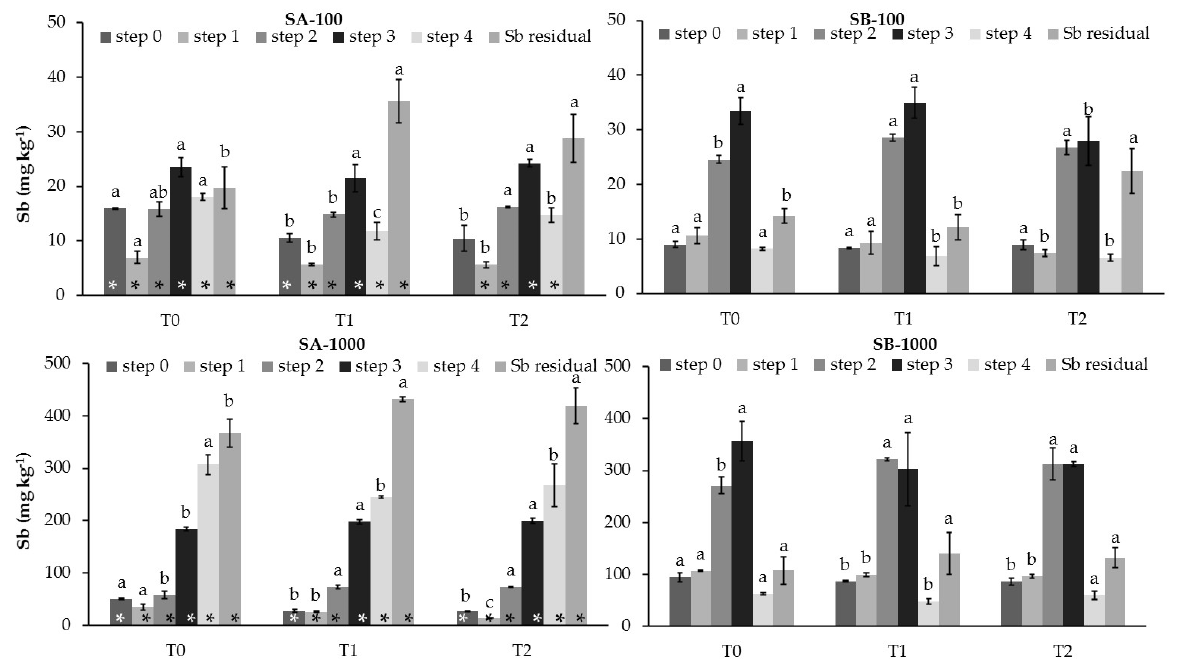
Figure 1. Sb extracted in amended and unamended Sb-polluted SA and SB soils in different SEP steps. Average values (histograms) and standard errors (bars) are reported. T0, T1 and T2 refer to MSWC addition, i.e., 0, 1 and 2%, respectively. Step 0: water-soluble Sb; step 1: exchangeable Sb; step 2: inner-sphere complexed Sb; step 3: Sb bound to amorphous Fe/Al (hydr)oxides; step 4: Sb bound to crystalline Fe/Al (hydr)oxides. For each soil and extraction step, different letters denote significant differences between treatments (Tukey–Kramer test; p < 0.05). For each extraction step, asterisks denote significant differences between SA-100 and SB-100, and between SA-1000 and SB-1000 (Student t-test; p < 0.05).